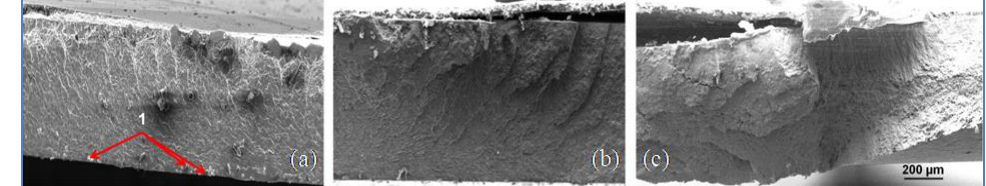
Fig. 7: Fractographs of shaft 2at different locations – (a,b) fatigue fractured regions, (c) overload